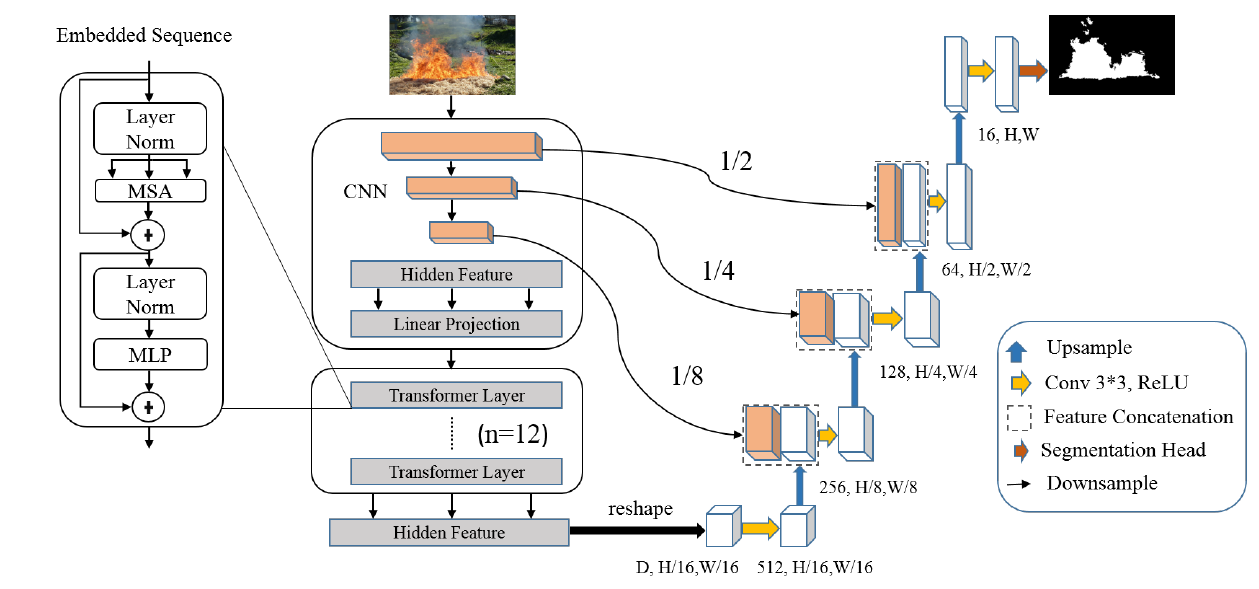
Figure 1. The proposed TransUNet architecture.